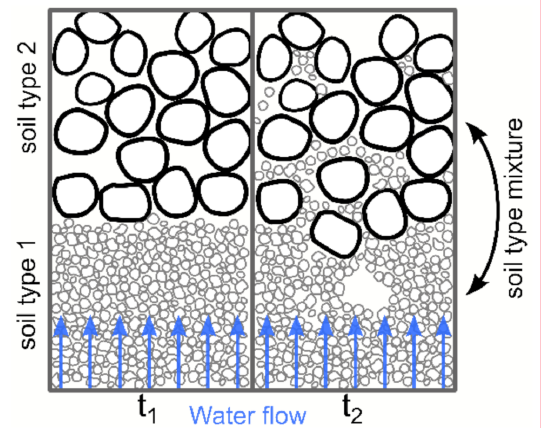
Figure 1. Erosion process during the